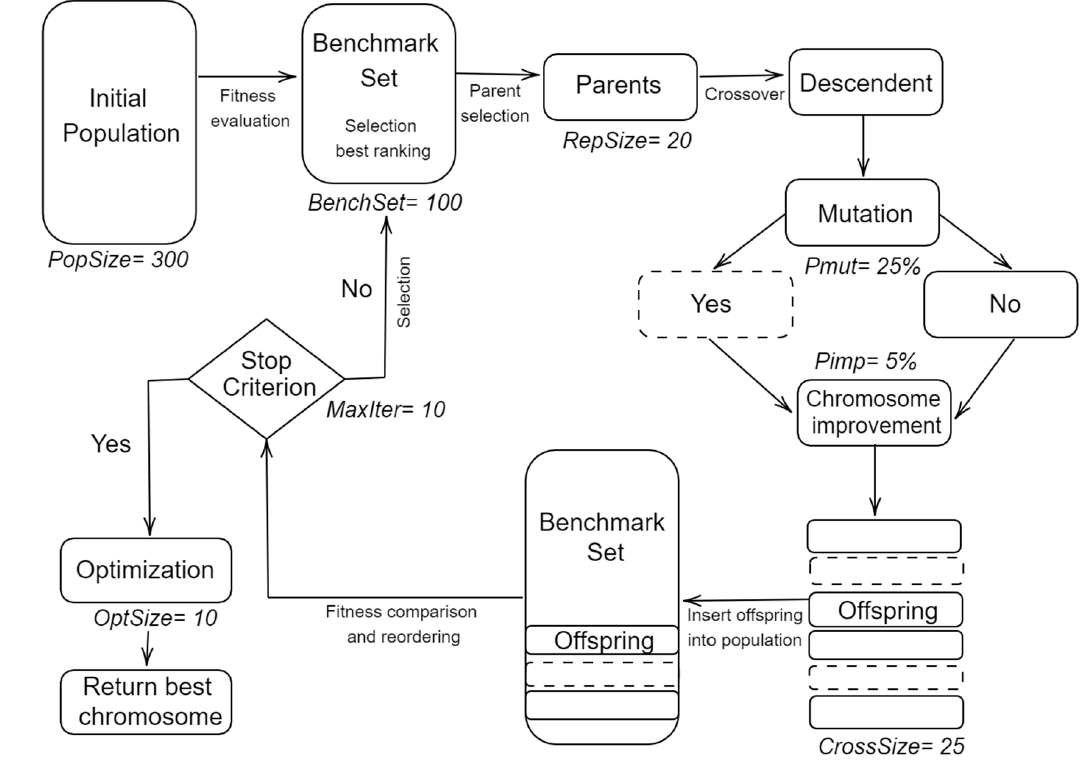
Figure 1. Hybrid genetic algorithm